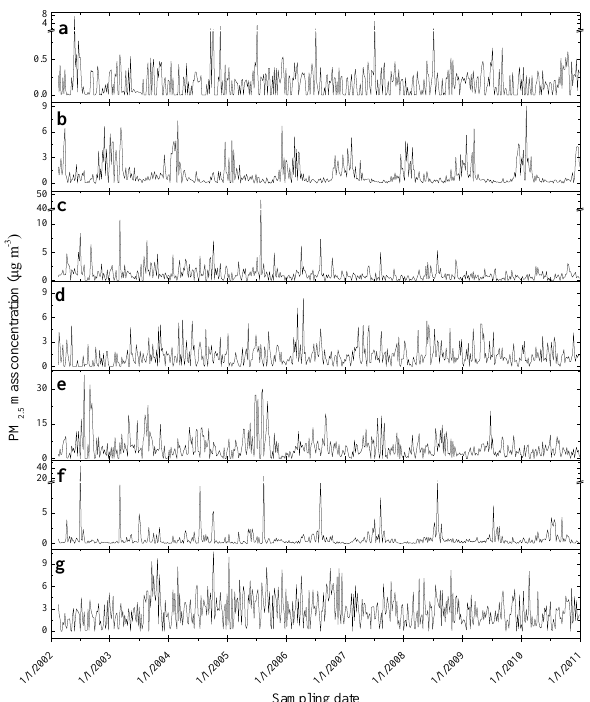
Table 2. Source contributions to PM 2 . 5 in Little Rock, Arkansas.